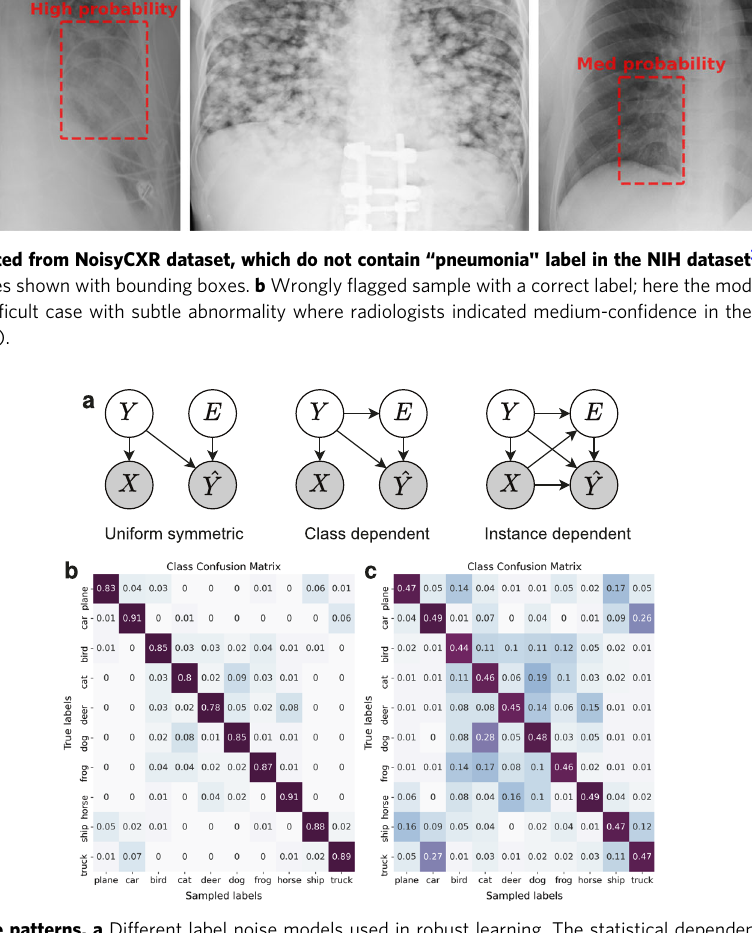
Fig. 6 Understanding label noise patterns. a Different label noise models used in robust learning. The statistical dependence between input image ( X ), true label ( Y ), observed label ( ^ Y ), and error occurrence ( E ) is shown with arrows (adapted from Frénay et al. 55 ). b – c CIFAR10H class confusion matrices (temperature τ = 2) for all samples ( b ) and dif fi cult samples only ( c